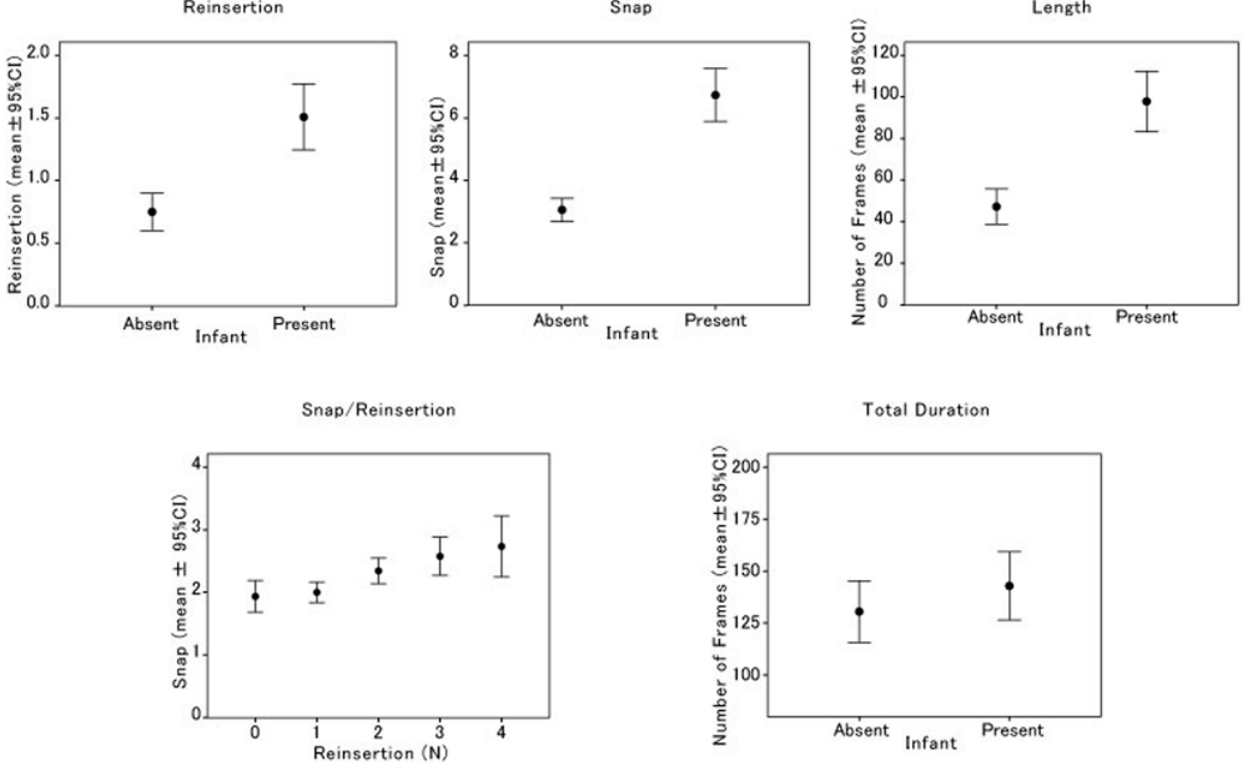
Figure 1. Summary of results of the analyses. Average scores of number of occurrences of reinsertion in a given tool-using bout (Reinsertion), of number of occurrences of snapping during each insertion (Snap), of length of each bout (Length), of overall mean number of snaps during each insertion as a function of number of occurrences of reinsertion in a tool-using bout (Snap/Reinsertion), and of total duration of a given tool-using episode (Total Duration) are computed across target adult females when the infant was in her proximity and when the infant was